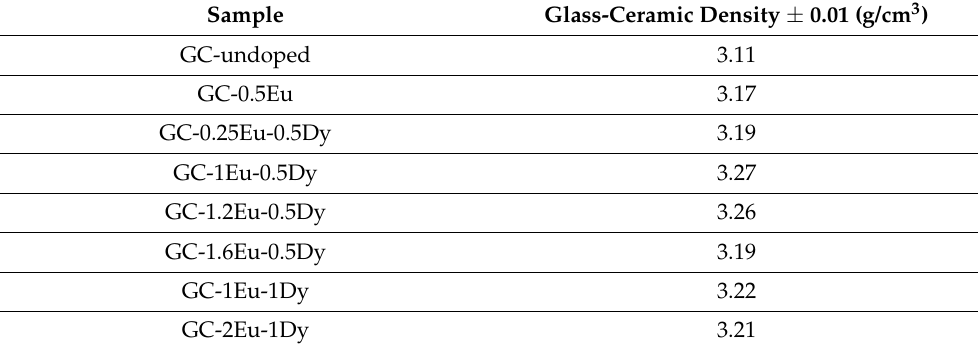
Table 5. Glass-ceramic